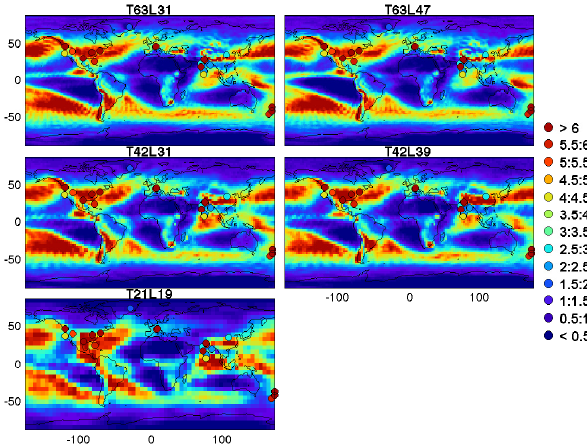
Fig. 8. Zonal mean air concentrations of 10 Be atoms (10 4 m − 3 ) with different resolutions. Tropopause pressure is highlighted in black. The altitude is shown only until 10 hPa with the middle atmosphere versions (L39 and L47).